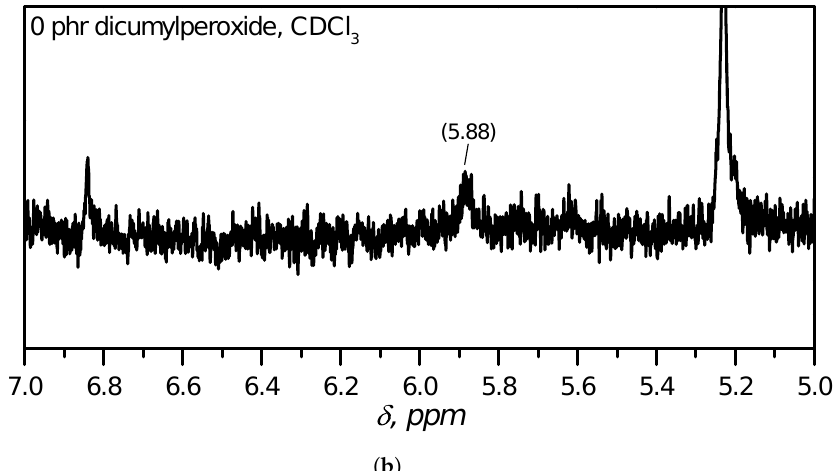
Figure A3. Full ( a ) 1 H NMR spectrum in CDCl 3 for the 0 dicumylperoxide solid silicone, and detailed spectrum ( b ) for the vinyl